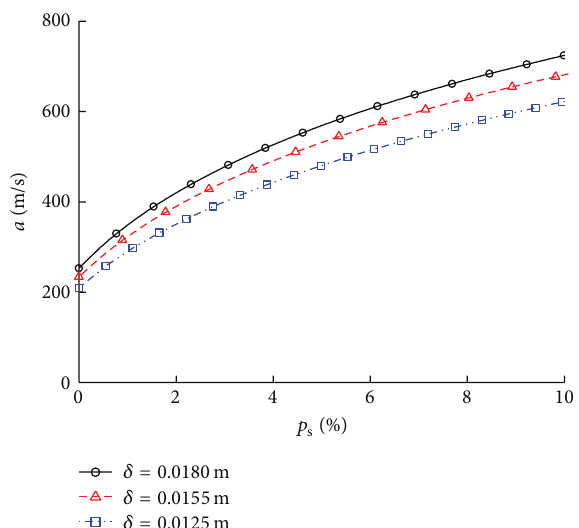
Figure 7: Influence of reinforcement ratio on the wave speed.